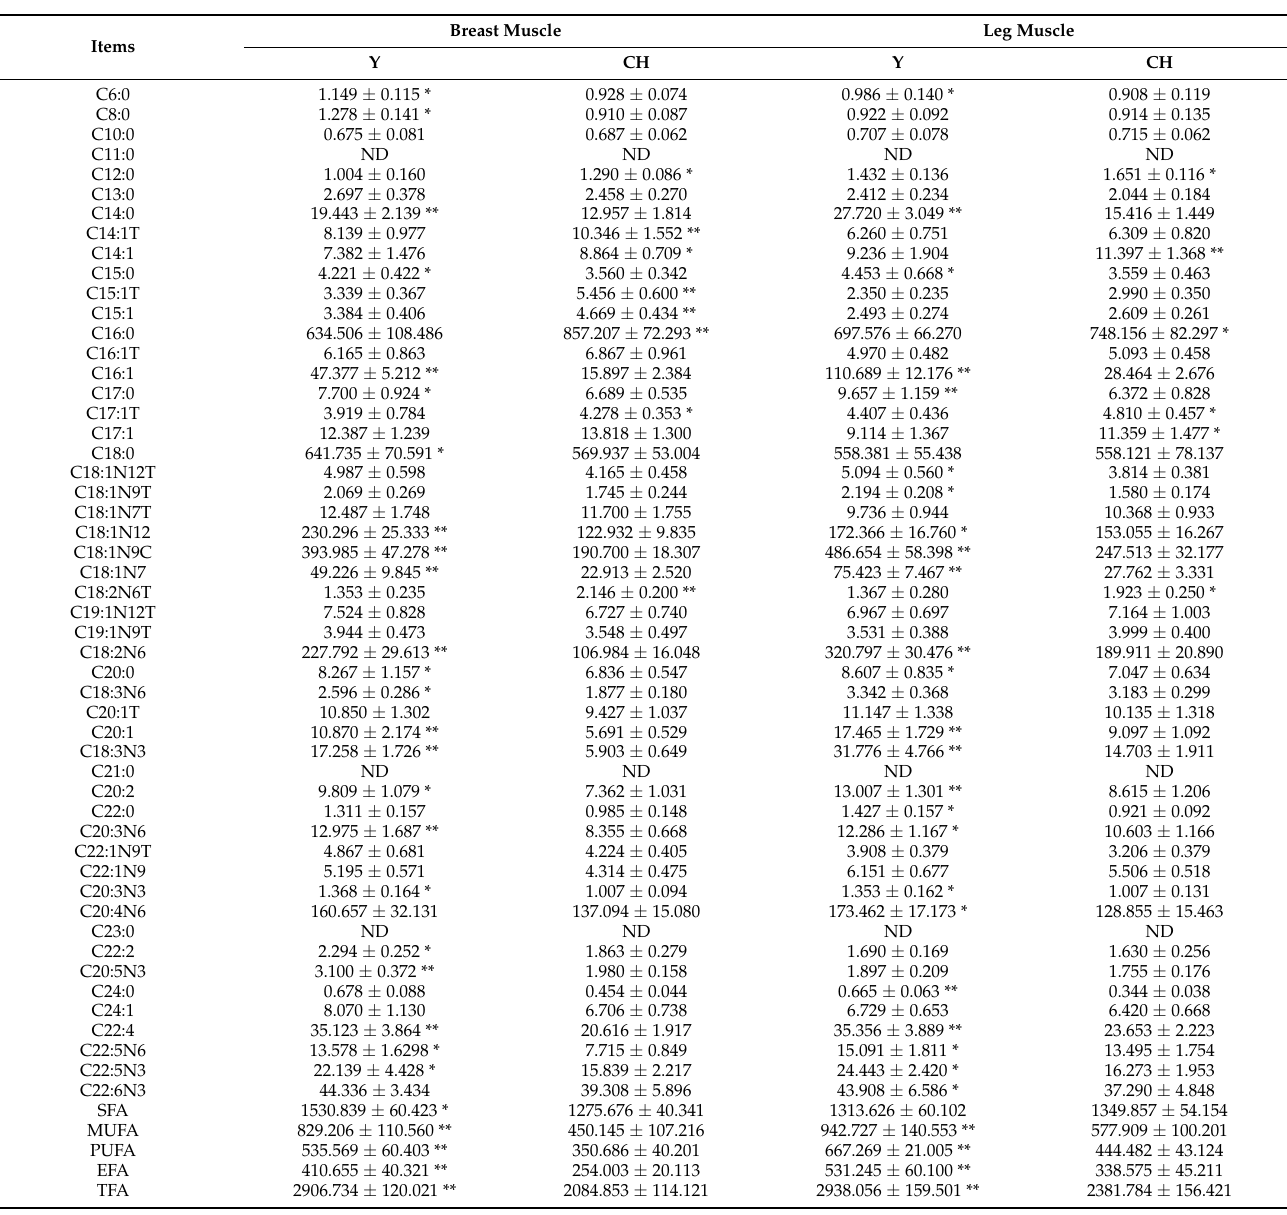
Table 5. Fatty acid content in muscles of